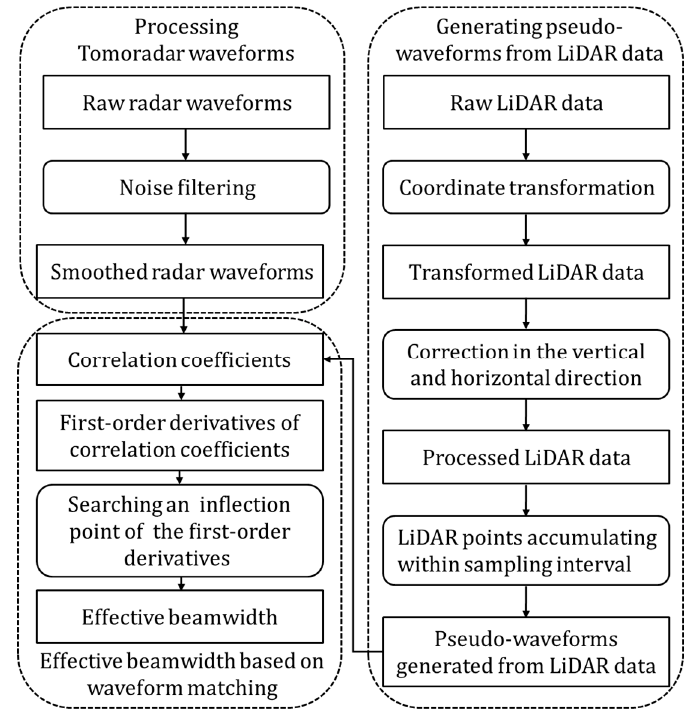
Figure 2. The flowchart of determining the effective beamwidth of Ku band profiling radar based on waveform matching method. The procedure includes three processing steps: processing Tomoradar waveforms; generating simulated-waveforms from lidar data and determining effective beamwidth.